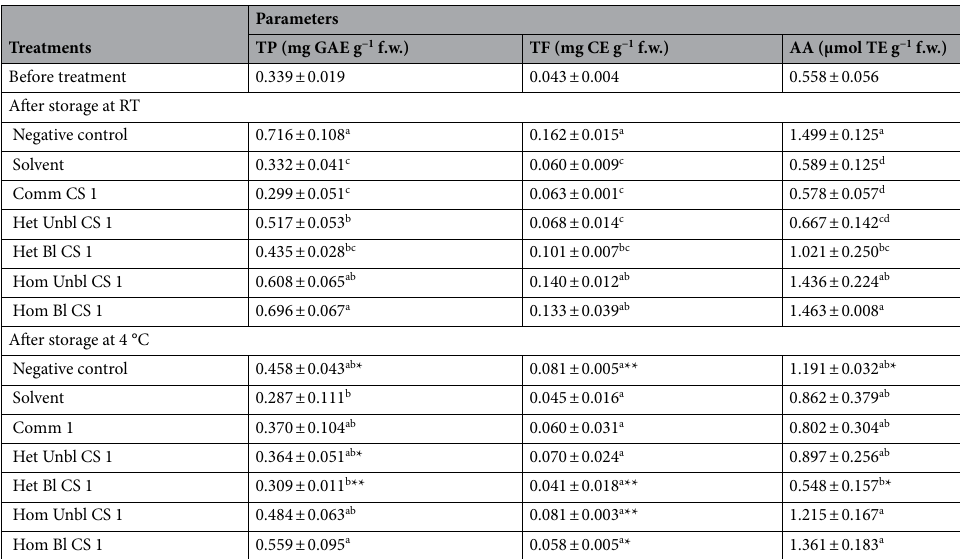
Table 4. Results of evaluation of total phenols (TP), total flavonoids (TF) and antioxidant activity (AA) on whole tomatoes, coated by dipping, after 30 days of storage at room temperature (RT) and 4 °C. Treatments: untreated fruits (negative control), solvent only, coating with heterogeneous unbleached (Het Unbl CS), heterogeneous bleached (Het Bl CS), homogeneous unbleached (Hom Unbl CS), homogeneous bleached (Hom Bl CS) and commercial (Comm CS) chitosan. GAE, gallic acid equivalents. CE, catechin equivalents. TE, Trolox equivalents. Means followed by different letters in the column are significantly different by Mann– Whitney U test (p < 0.05). Each trial contained three triplicates of whole tomatoes per each treatment. Asterisks indicate significant differences (*p < 0.05; **p < 0.01) between the two storage temperatures within the same treatment, according to Mann–Whitney U